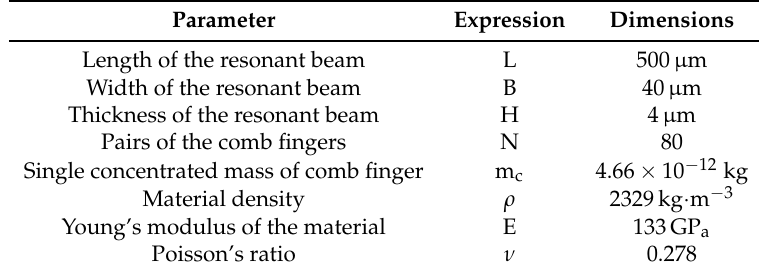
Table 1. Properties of the resonant beam.